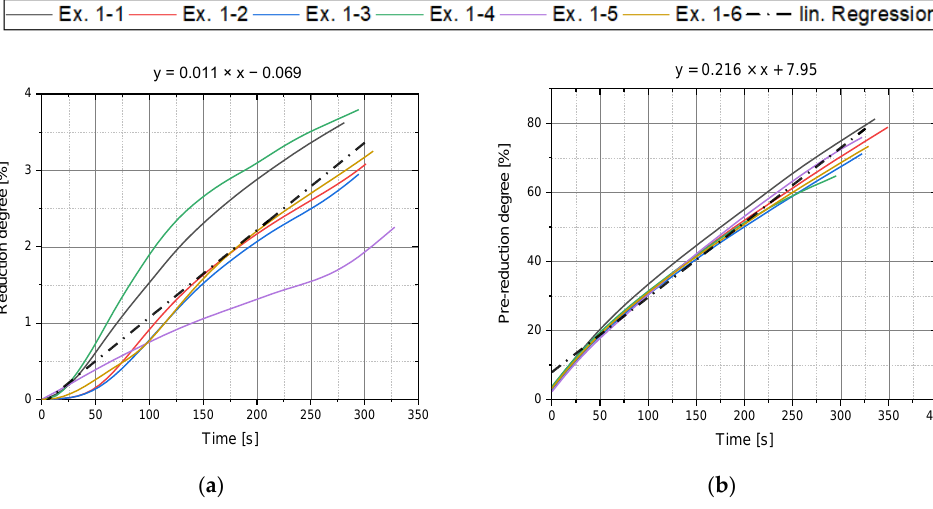
Figure 4. Pre ‐ melting ( a ) and pre ‐ reduction trend ( b ) Ex.1–1 to Ex. 1–6.